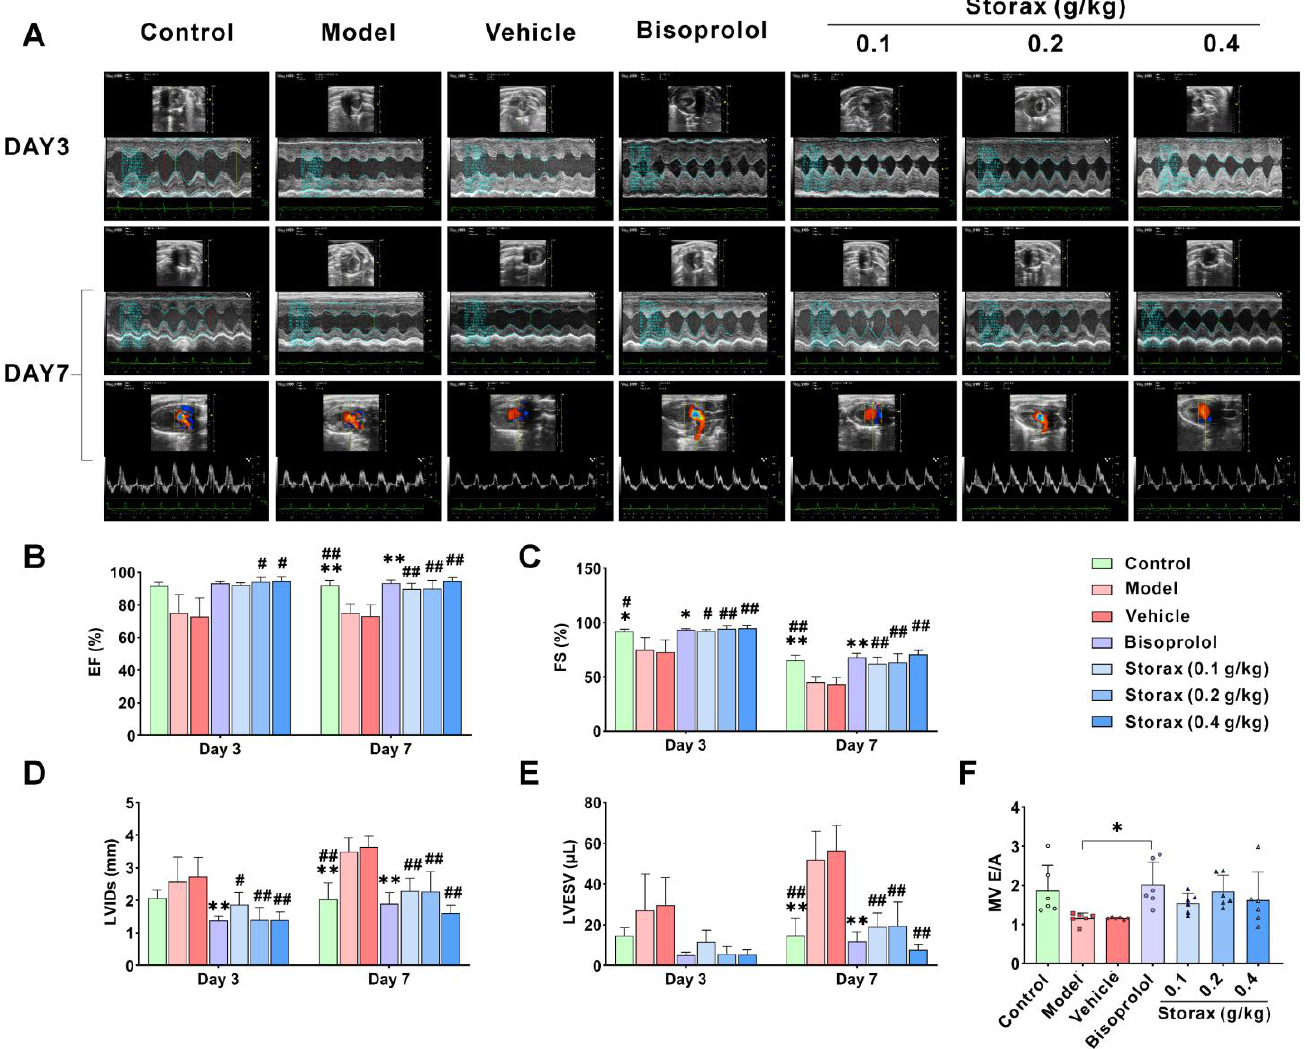
Figure 3. Effect of storax on cardiac function in ISO-induced AMI rats. ( A ) Representative images of M-mode echocardiography and mitral pulse Doppler. ( B ) Ejection fraction (EF). ( C ) Shortening fraction (FS). ( D ) Left ventricular end-systolic inner diameters (LVIDs). ( E ) Left ventricular end- systolic volume (LVESV). ( F ) MV E/A. Results are presented as mean ± SD (n = 6). One-way ANOVA followed by Bonferroni’s post hoc test: * p < 0.05, ** p < 0.01 vs. model group; # p < 0.05, ## p < 0.01 vs. vehicle group.